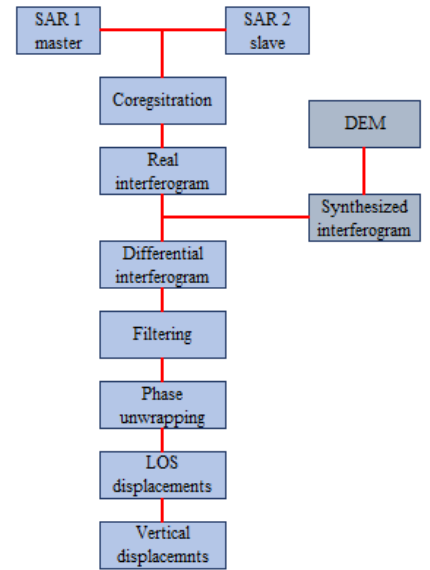
Figure 2. General scheme of the DInSAR processing technique applied in this study In the result a differential interferogram that contained interferometric bands representing surface displacements corresponding to half the wavelength used by the SAR system (Sentinel-1 ʎ = 5.6 cm) was obtained. The differential interferogram was then subjected to a filtering process to eliminate the impact of SAR registration errors and atmospheric errors. The phase unwrapping process consisting of